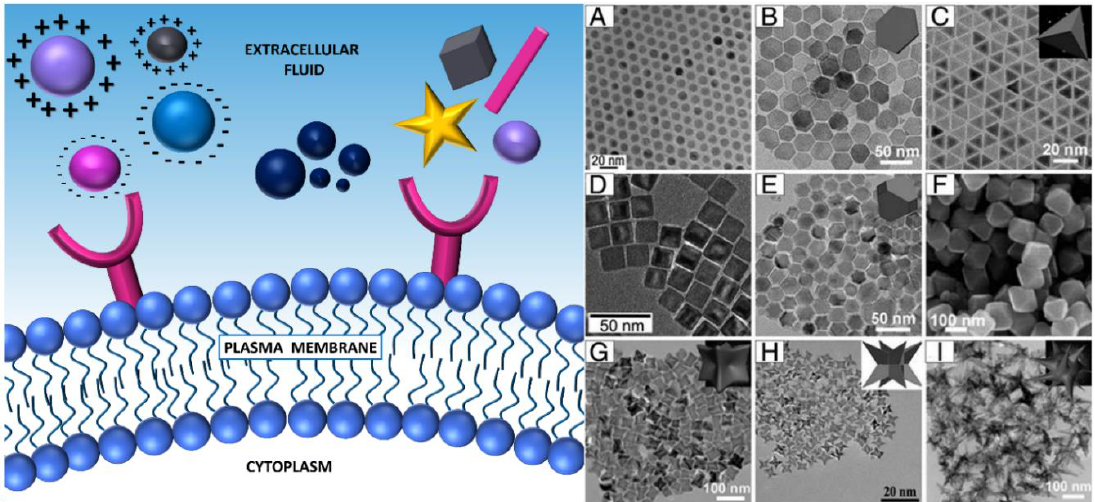
Figure 19. ( Left ) Physicochemical factors that affect cellular uptake of nanoparticles: Surface charge, size and shape. ( Right ) Different morphologies of iron oxide nanoparticles. Reproduced with permission from: [206], published by Ivyspring, 2018.